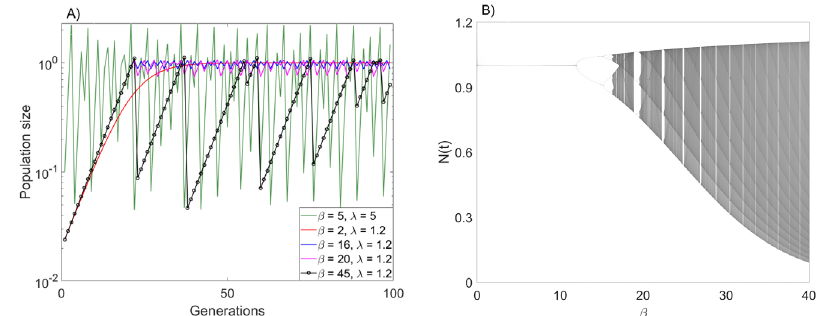
Fig. 1 The dynamic complexity of the basic model. A Examples of population dynamics generated by model (2). Shown are convergence to steady state for β = 2, λ = 1.2 (red line), stable periodic oscillations for β = 16, λ = 1.2 (blue line), chaotic dynamics when β = 20, λ = 1.2 (magenta line) and β = 5, λ = 5 (green line), and boom-bust chaotic dynamics when β = 45, λ = 1.2 (black line with individual generations shown by circles). Note the almost exponential multi-generation growth phases in the boom-bust regime, followed by a single-generation bust. B Bifurcation diagram for Eq. (2) for λ = 1.2. Both panels computed with K